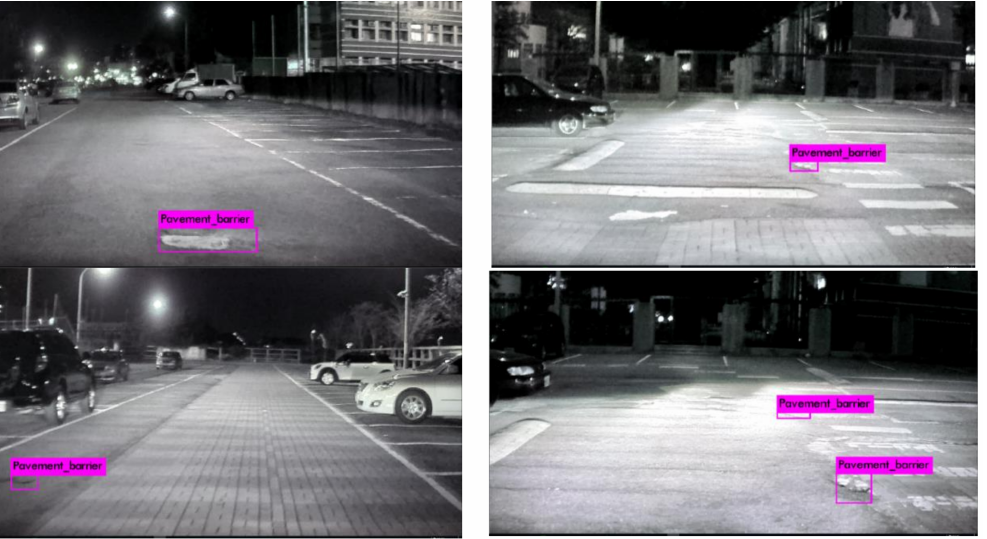
Figure 10. Pothole recognition results in low-illumination night environment.